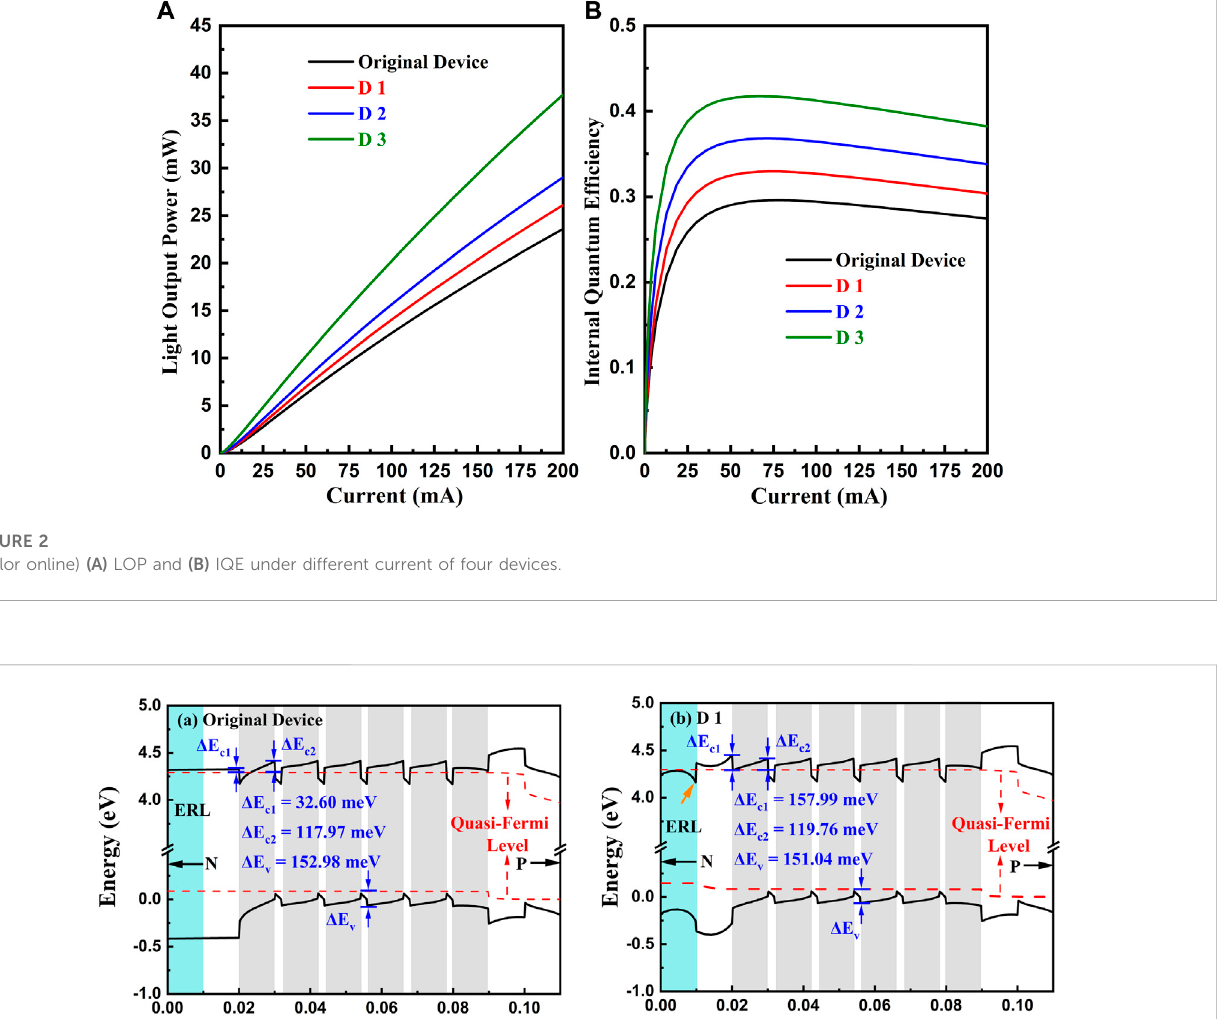
maximum potential barrier height for an electron in the front of the fi rst QB. It can be seen that the values of Δ E c1 are quite different due to the different spontaneous and piezoelectric polarization caused by the inserted EDLs. The calculated value of Δ E c1 for the original device is only 32.60 meV. By inserting the new EDL layers,